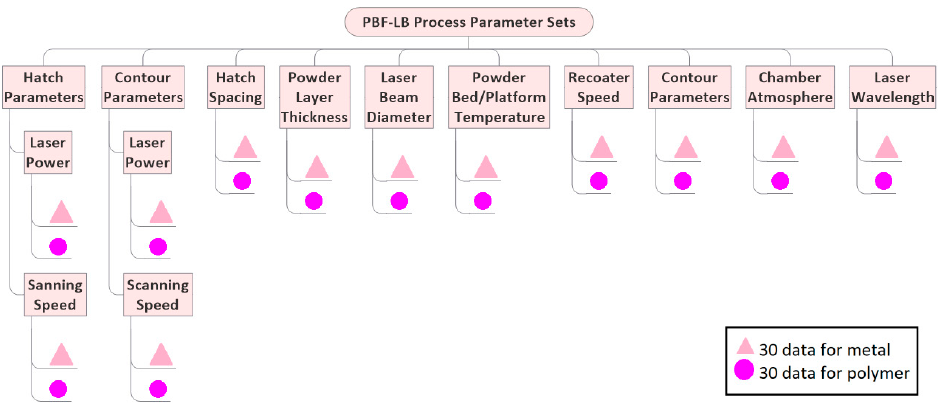
Figure 5. Participant-dependent PBF-LB process parameter sets and number of data generated for each property.